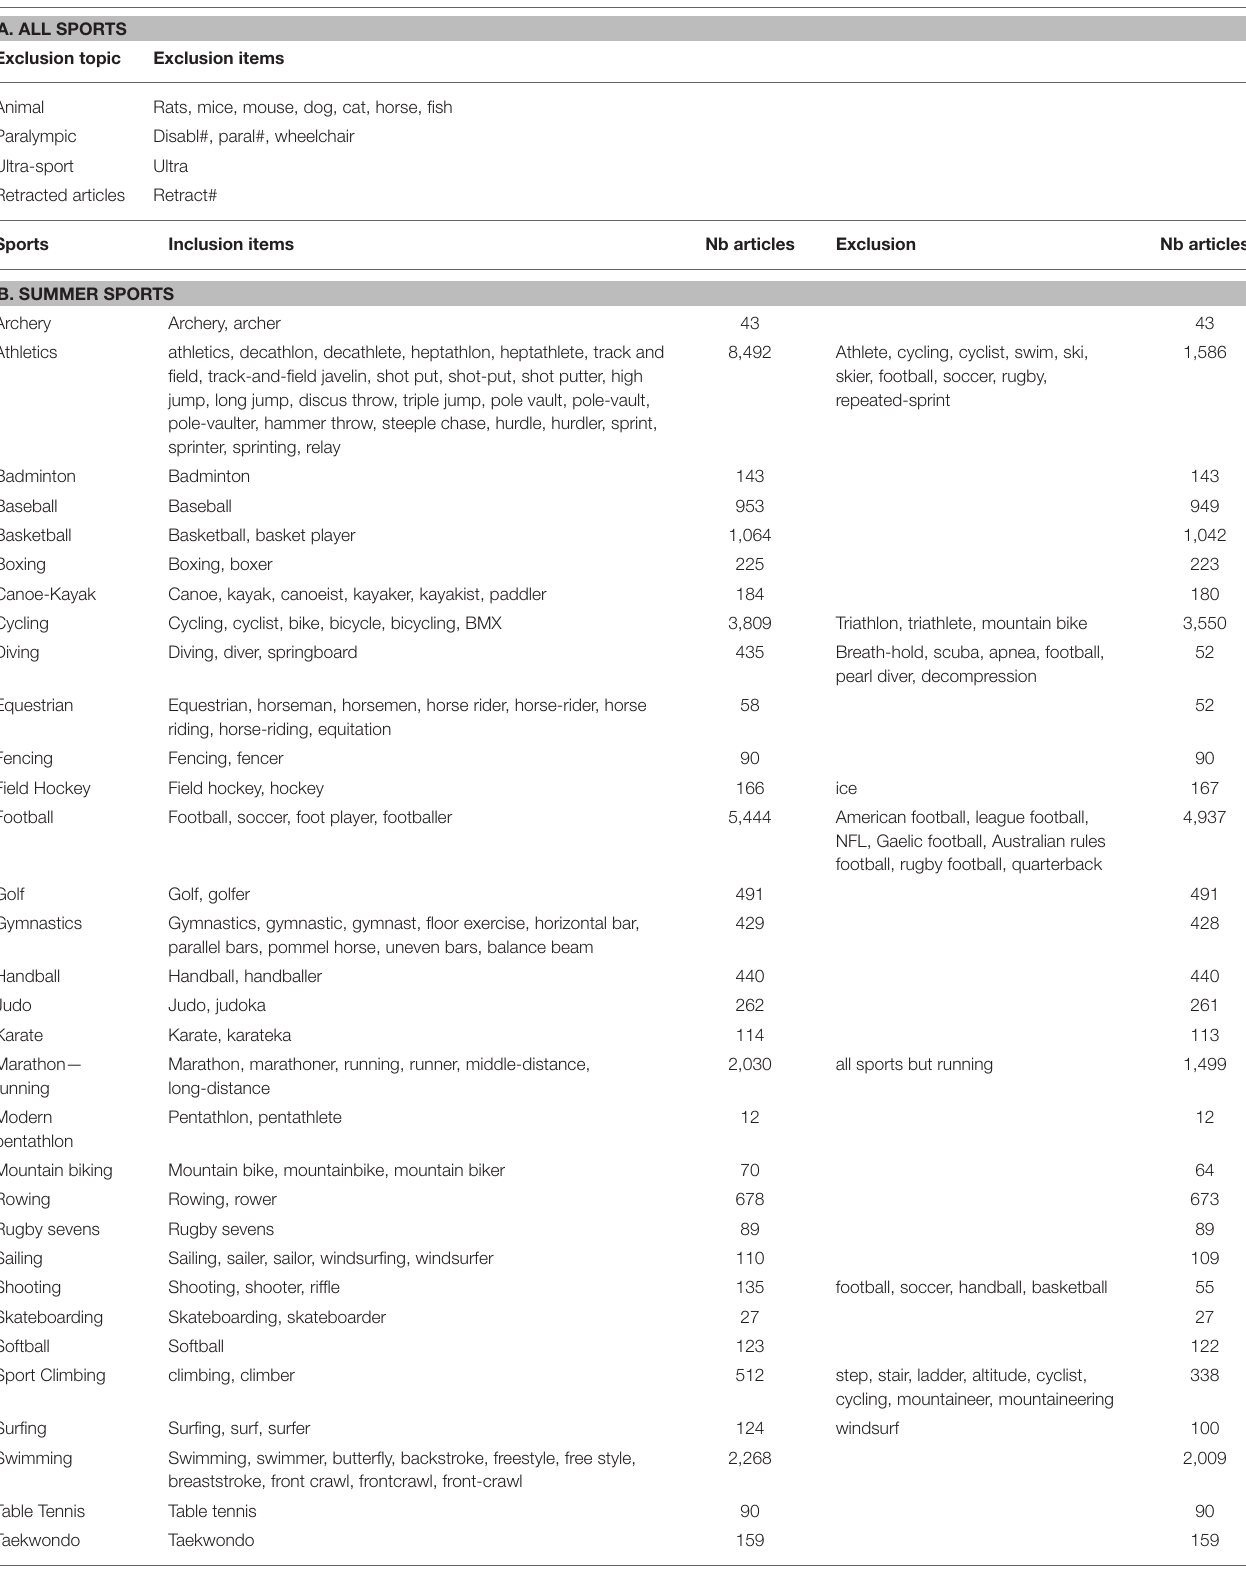
TABLE 3 | Inclusion and exclusion criteria in the search for (A) all sports, (B) the summer, and (C) winter Olympic sports.